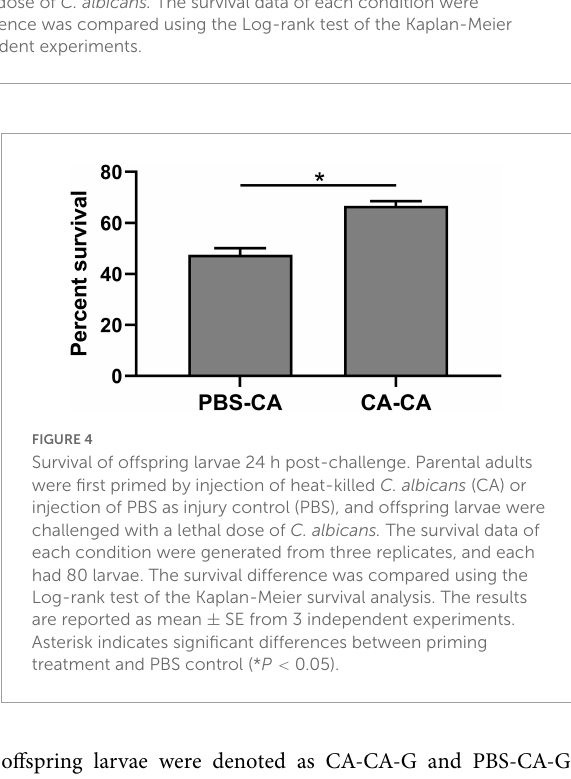
Mortality of adults was recorded daily for 7 days after the challenge ( Figure 1A ).